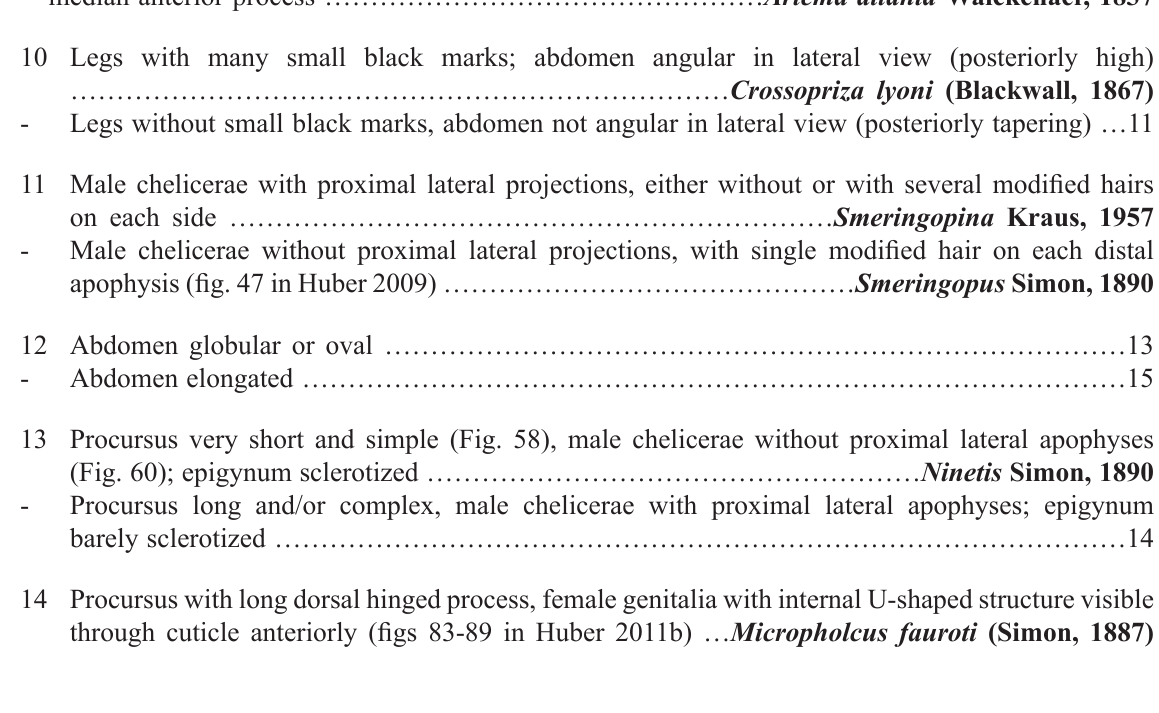
9 Procursus with prominent distal spine; female carapace with posterior median cone acting against frontal plate on abdomen; epigynum with median anterior process - Procursus short, without distal spine; female carapace without posterior cone; epigynum without 10 Legs with many small black marks; abdomen angular in lateral view (posteriorly high) - Legs without small black marks, abdomen not angular in lateral view (posteriorly tapering) …11 11 Male chelicerae with proximal lateral projections, either without or with several modified hairs - Male chelicerae without proximal lateral projections, with single modified hair on each distal